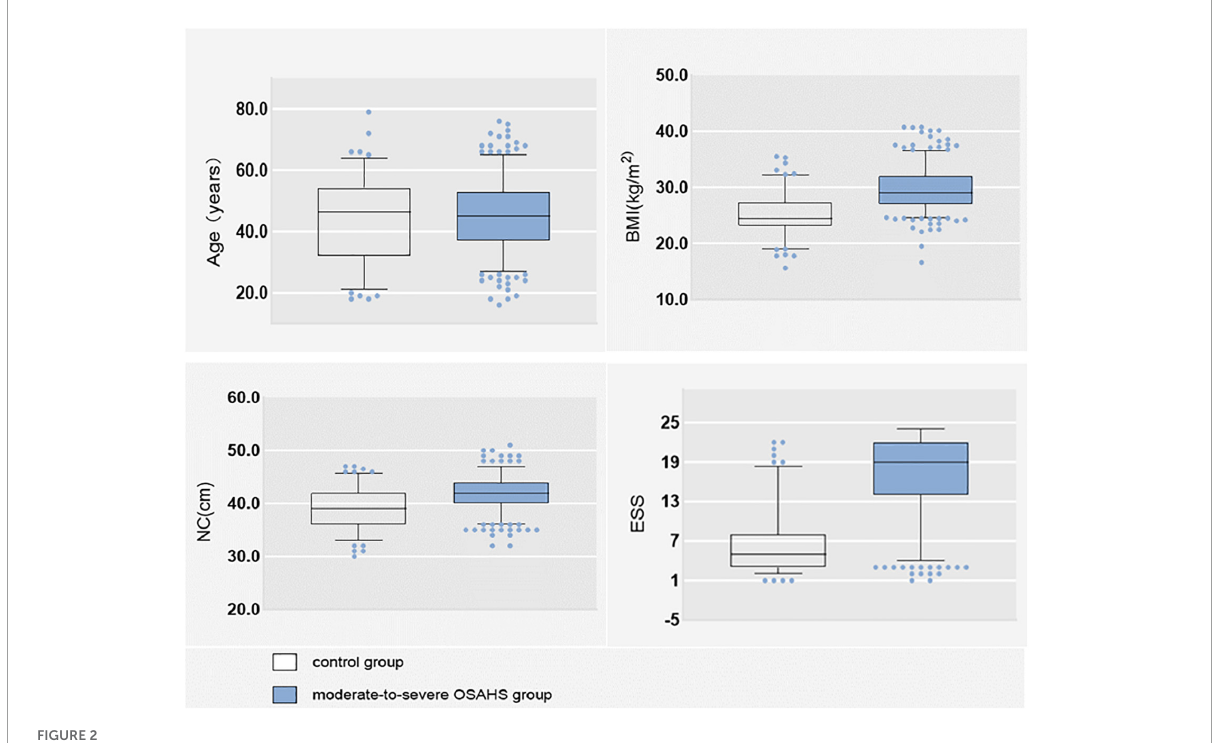
FIGURE2 Box plot of age, BMI, NC, and